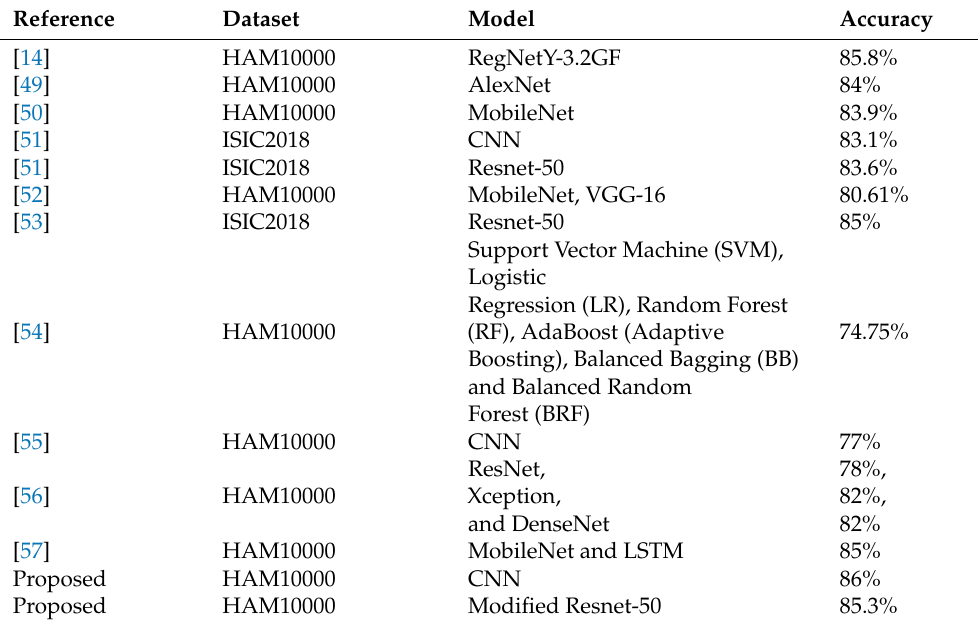
Table 7. Comparison with other